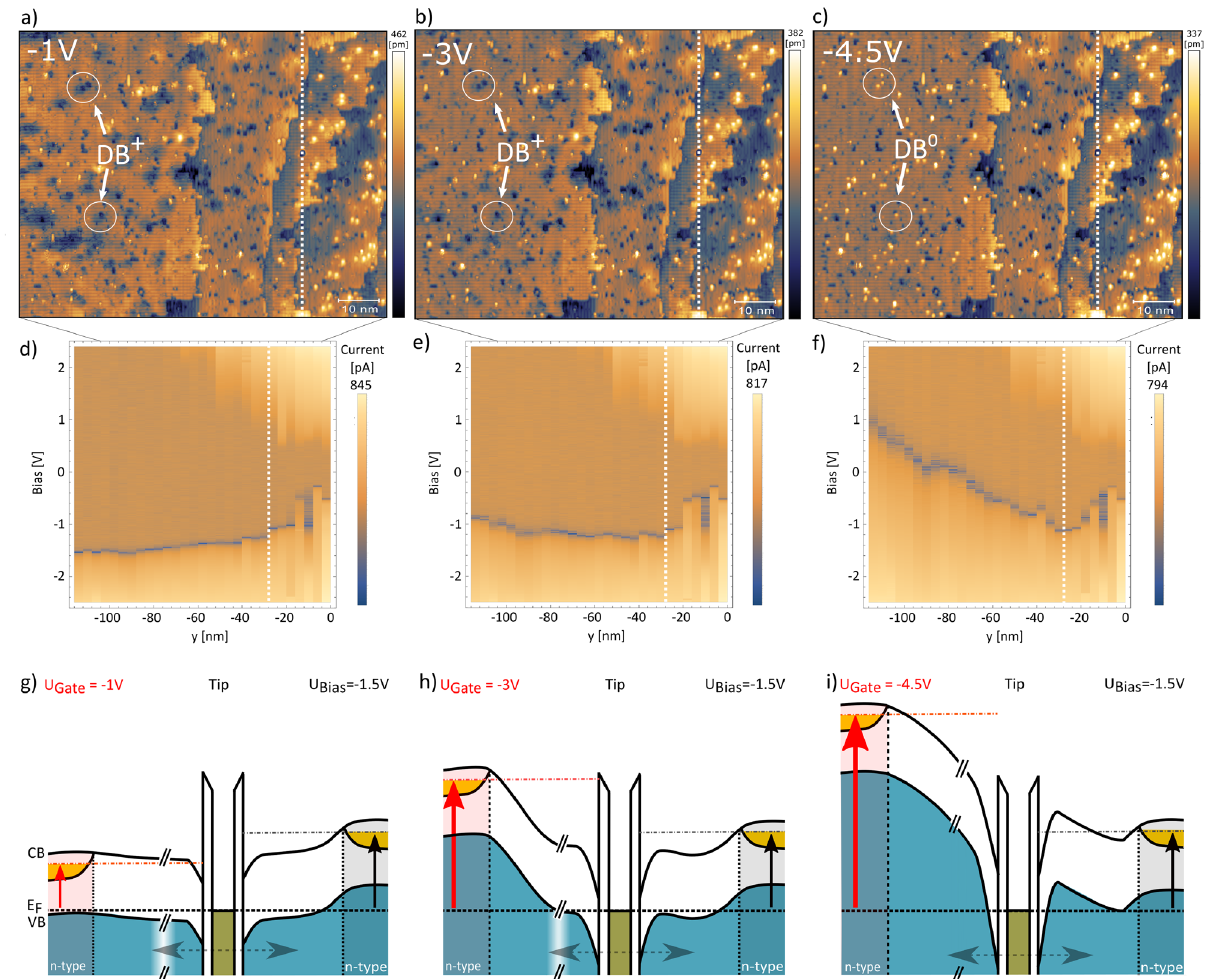
Figure 5. Characteristics and gate influence on surface feature at the tip-gap-source interface with applied gate bias: ( a–c ) individual STM topography images taken at different gate voltages (Fixed U Bias = − 1.5 V, 100 pA) and their corresponding Log-current plots ( d–f) ) (as acquired along the white dashed line indicated in Fig. 3b). Two white circles point out DBs in the gap region that change their appearance from depression to protrusion with increasing gate voltage. Energy diagrams ( g–i ) of the whole gate-gap-source-tip system for different gate